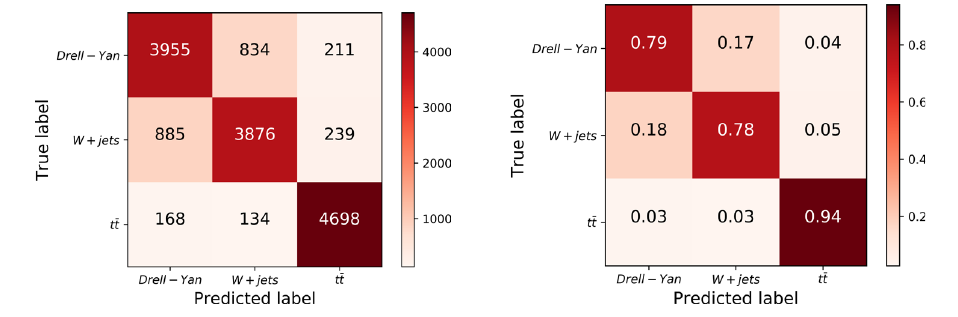
Figure 3. Confusion matrices for the test set using convolutional neural networks.